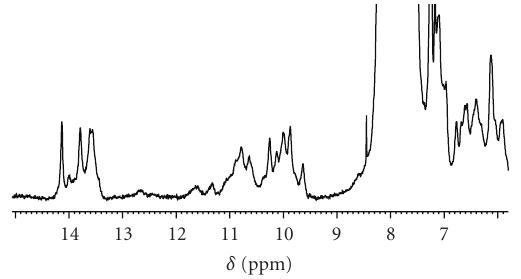
Figure 5: NMR spectrum of parallel duplex 7 (Conditions 50 mM MgCl 2 , 10mM sodium